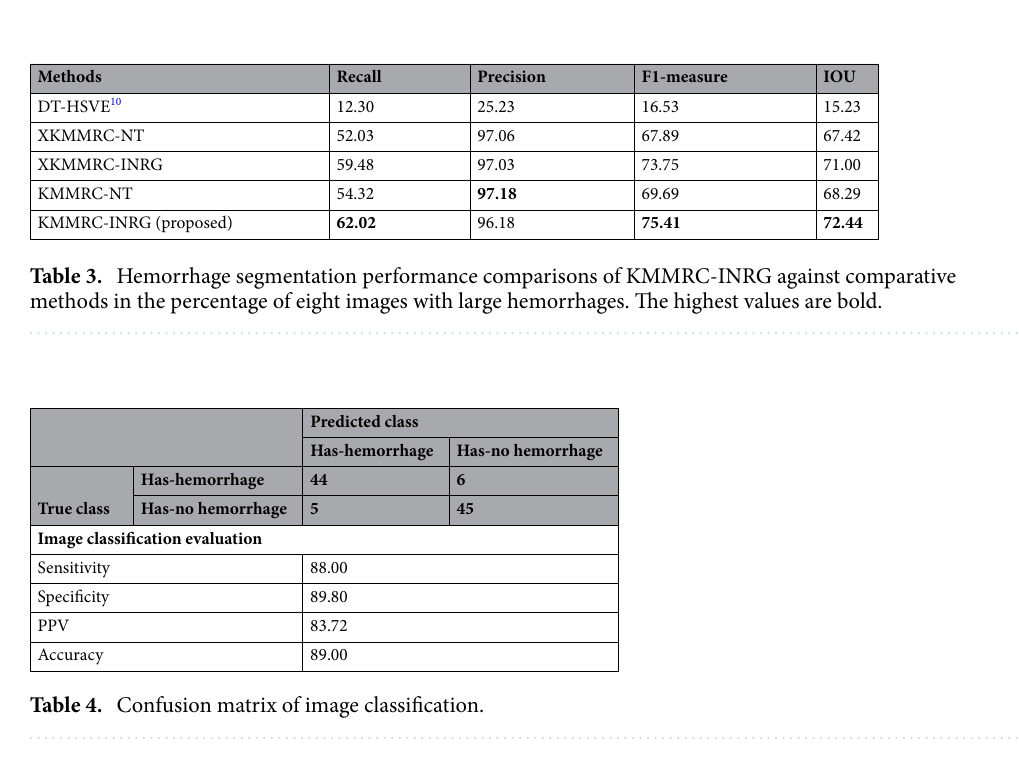
Table 2. Hemorrhage segmentation performance comparisons of KMMRC-INRG against comparative methods in the percentage of all images. The highest values are bold.